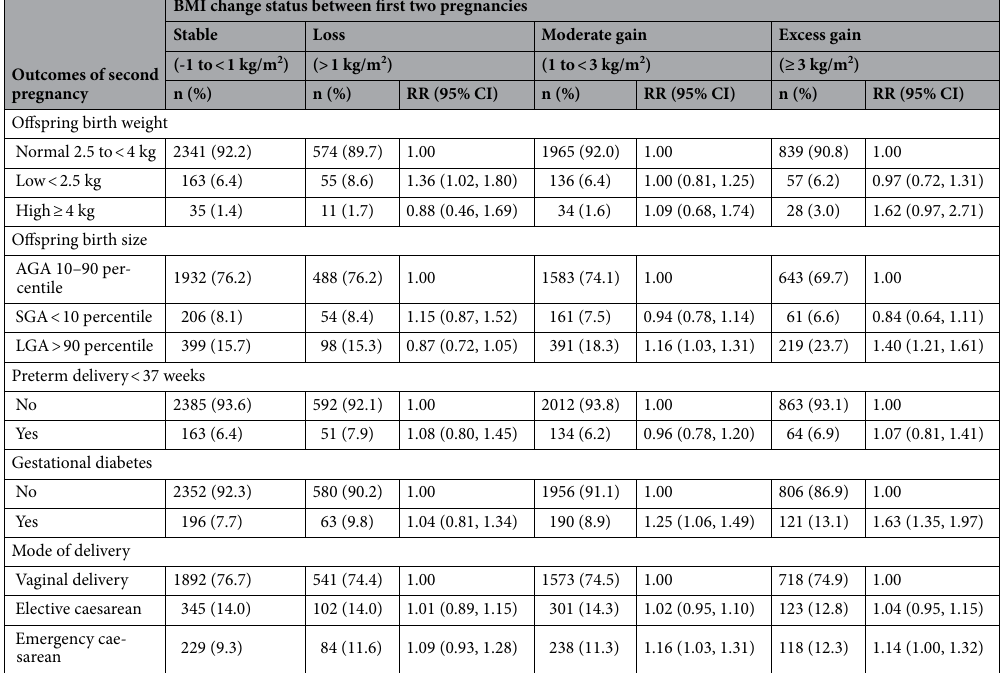
Table 2. Association between interpregnancy BMI change status and outcomes of second pregnancy. Risk ratios are adjusted for maternal age and BMI at 12-week gestation in the first pregnancy, ethnicity, interpregnancy interval and respective pregnancy outcomes in the first pregnancy. BMI stable (− 1 to < 1 kg/ m 2 ) serves as the reference group. BMI, body mass index; RR, risk ratio; CI, confidence interval; AGA, appropriate for gestational age; SGA, small-for-gestational-age; LGA, large-for-gestational-age.